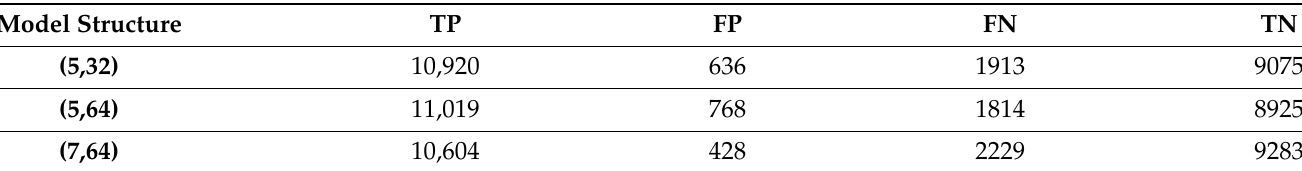
Table 7. The confusion matrix of the best performing model for each configuration. Positive label indicates attack sample. Model Structure